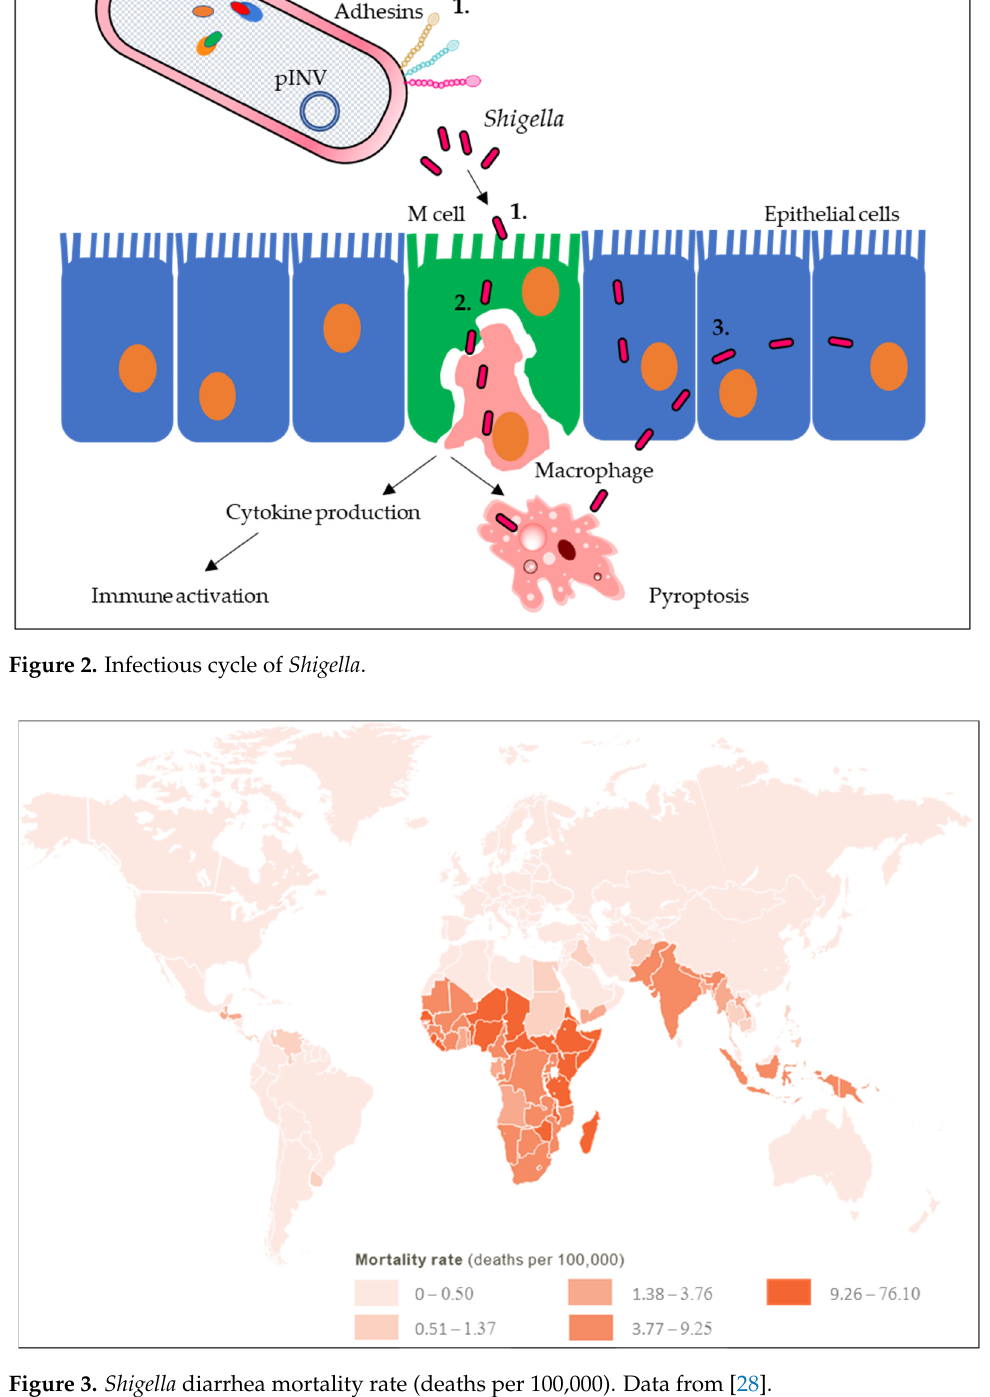
Figure 3. Shigella diarrhea mortality rate (deaths per 100,000). Data from [28].